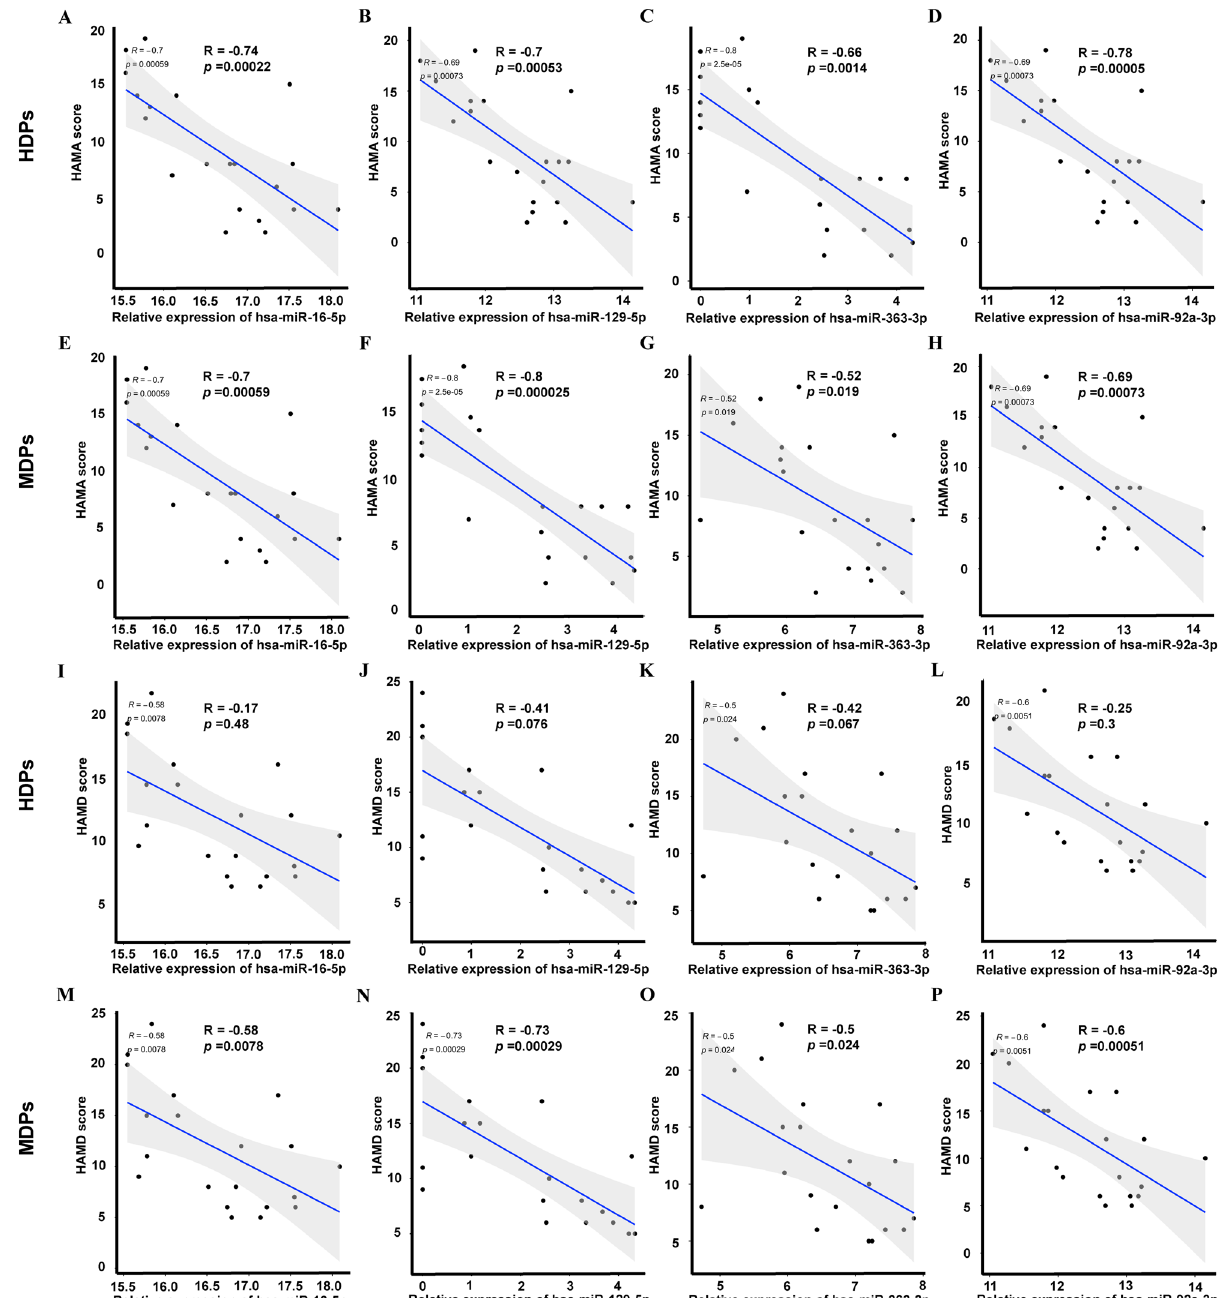
Figure 4. Correlation between exosomal DE-miRNAs and anxiety and depression in SUDs. ( A–H ) Correlation between exosomal DE-miRNAs and anxiety in SUDs. ( A , E ) correlation between hsa-miR-16-5p and HAM-A scores in HDPs and MDPs, respectively; ( B,F ) correlation between hsa-miR-129-5p and HAM-A scores in HDPs and MDPs, respectively; ( C , G ) correlation between hsa-miR-363-3p and HAM-A scores in HDPs and MDPs, respectively; ( D , H ) correlation between hsa-miR-92a-3p and HAM-A scores in HDPs and MDPs, respectively. ( I–P ) Correlation between exosomal DE-miRNAs and anxiety in SUDs. ( I , M ) correlation between hsa-miR-16-5p and HAM-D scores in HDPs and MDPs, respectively; ( J , N ) correlation between hsa-miR-129-5p and HAM-D scores in HDPs and MDPs, respectively; ( K , O ) correlation between miR-363-3p and HAMD in HDPs and MDPs, respectively; ( L , P ) correlation between miR-92a-3p and HAMD in HDPs and MDPs, respectively. The number on X-axis stands for reads calculated by TPM, the number on Y-axis stands for scores of HAM-A/HAM-D. MDPs Exosomes obtained from methamphetamine-dependent patients, HDPs Exosomes obtained from heroin-dependent patients, HCs Exosomes obtained from healthy controls, SUDs substance use disorders, HAM-A Hamilton Anxiety Rating Scale, HAM-D Hamilton Depression Rating Scale, TPM transcript per